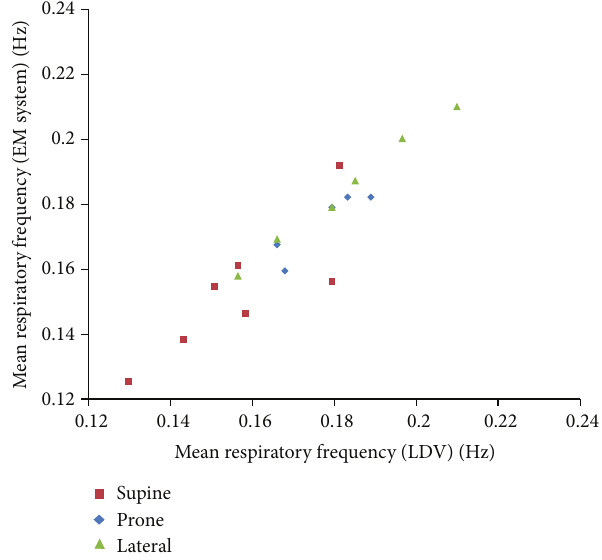
Figure 9: Scatter plot of mean respiratory frequencies ( 𝑓 𝑅 ): LDVi versus proposed method (supine, prone, and lateral; 𝐷 = 100